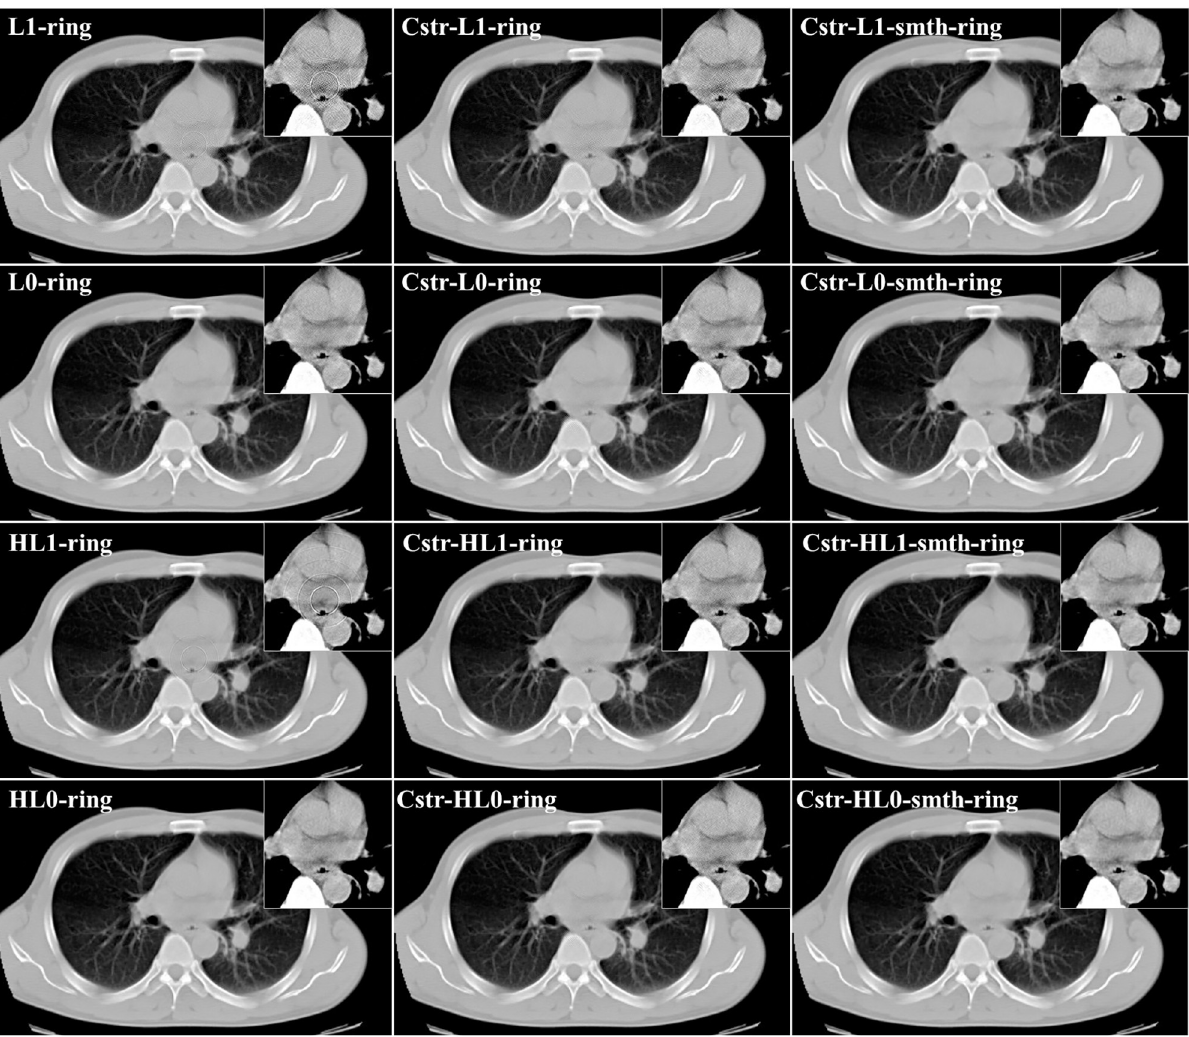
Fig 6. Comparison of reconstruction images between the proposed algorithms and their angular constrained forms for the first study case (noise-free, non-adjacent error detector bins, and angular-independent error case).